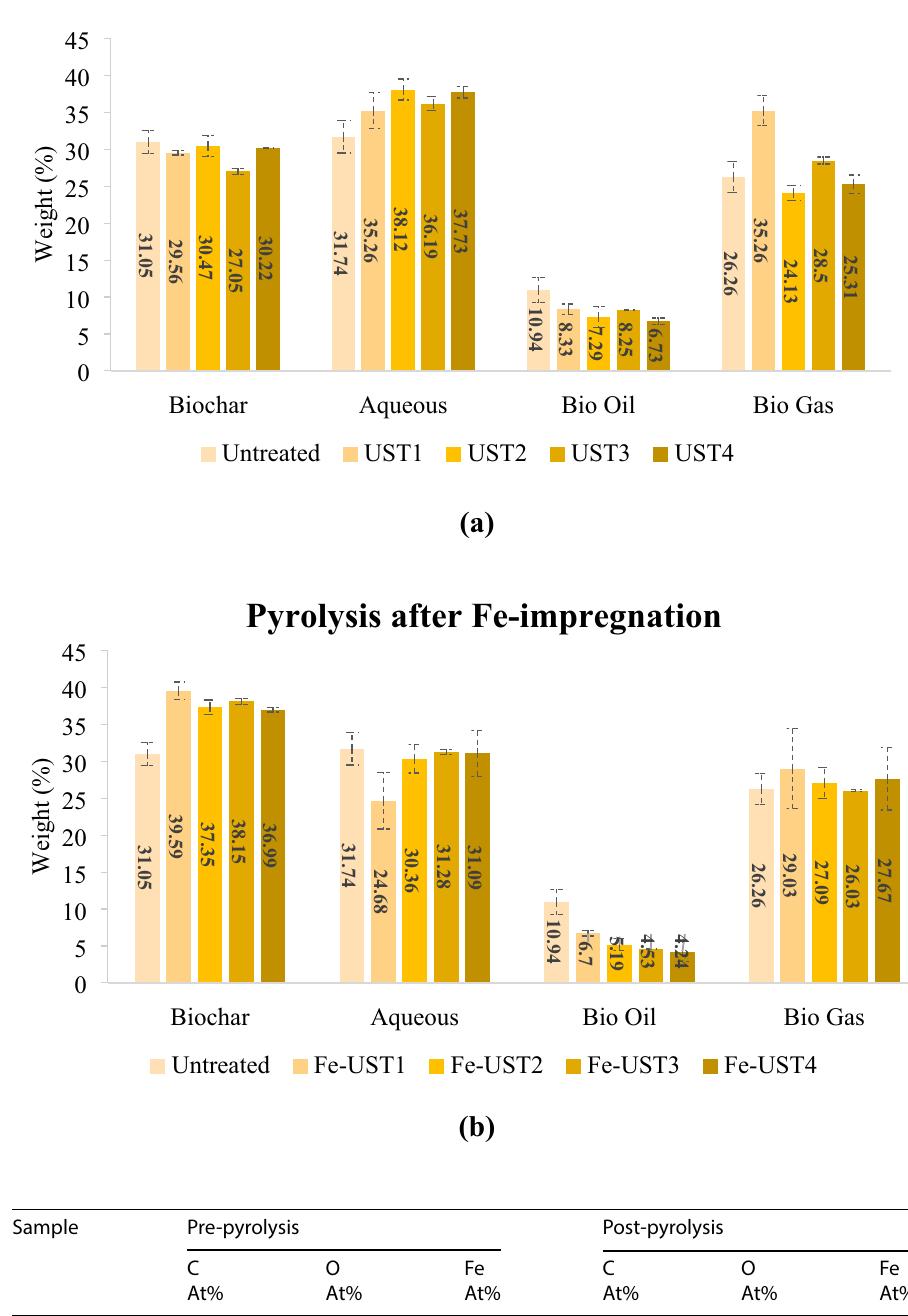
Fig. 3 Pyrolysis product distribution of pre and post- pyrolysis methods a product yield for pyrolysis without Fe-Impregnation b product yield for pyrolysis after Fe- impregnation